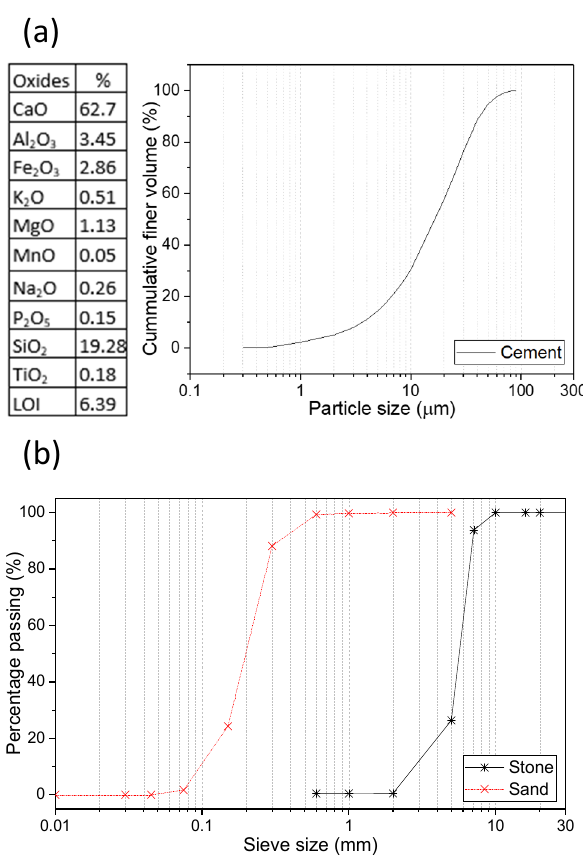
Figure 4. Properties of the dry constituents: (a) Cement composition and size distribution; (b) Sand and stone size